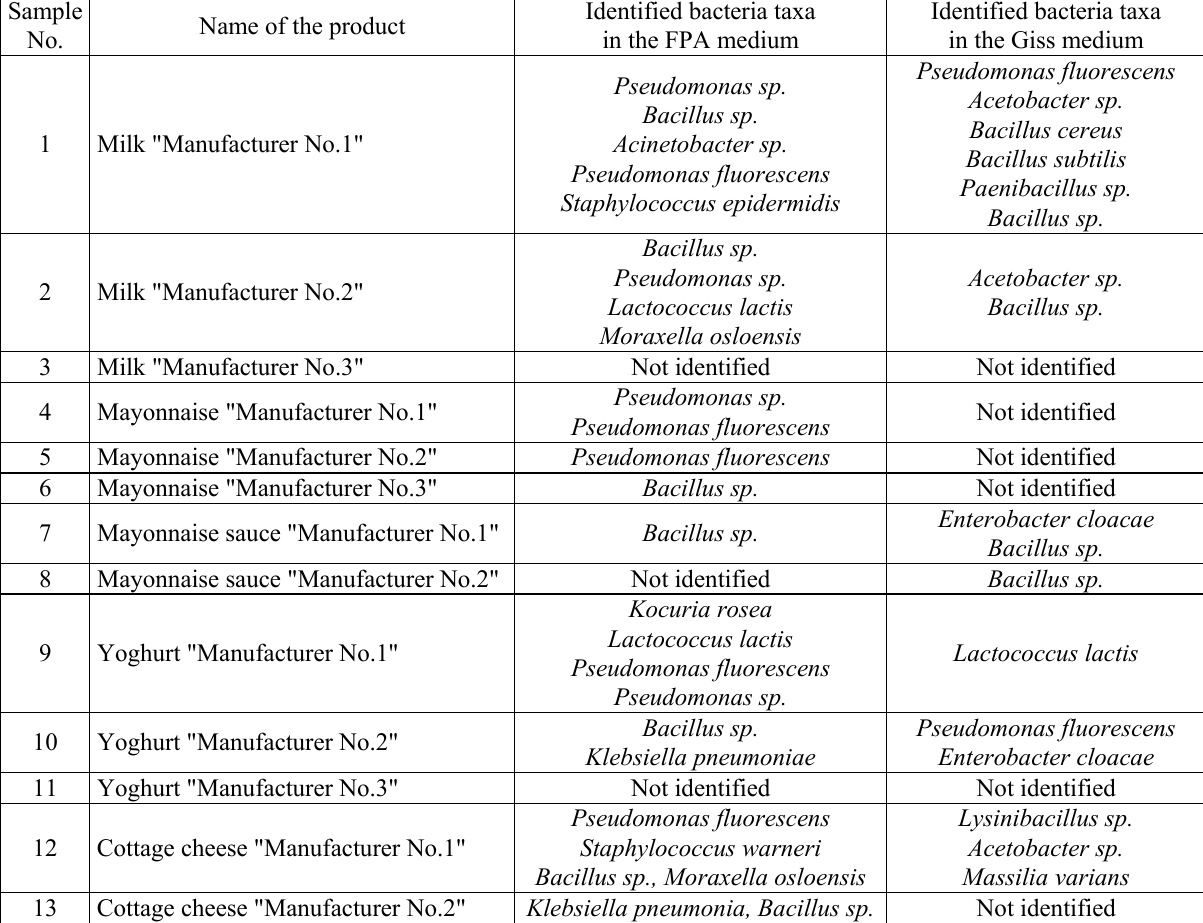
Table 5. Comparative microbiological analysis when seeding in the FPA and Giss nutrient media